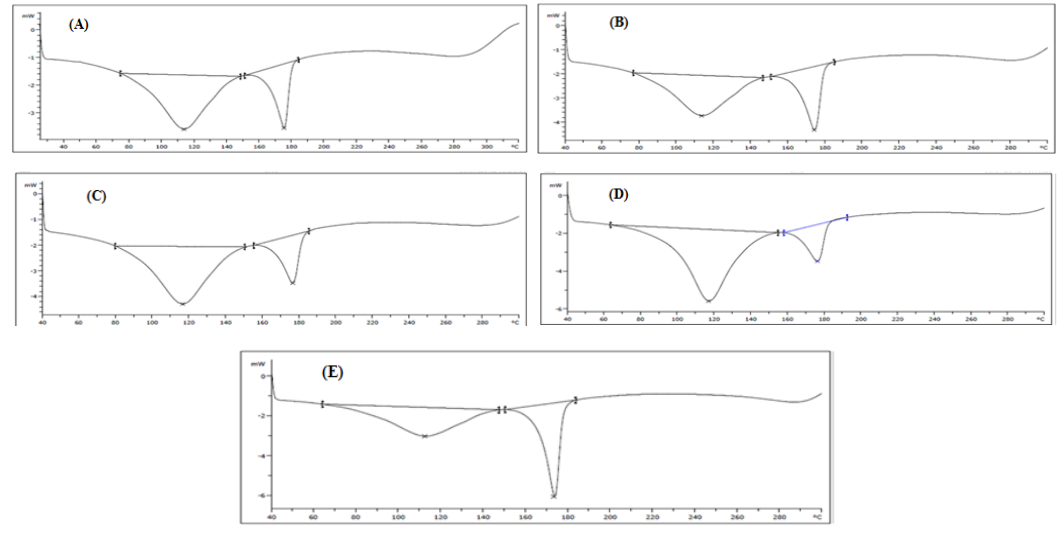
Figure 2. DSC thermograms of G2 (A), G4 (B), G5 (C), G6 (D) and G7